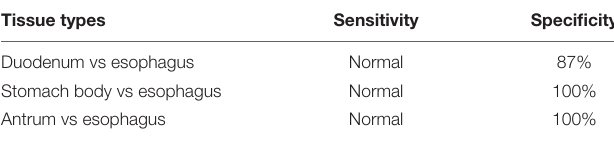
TABLE 4 | Normal tissue classification